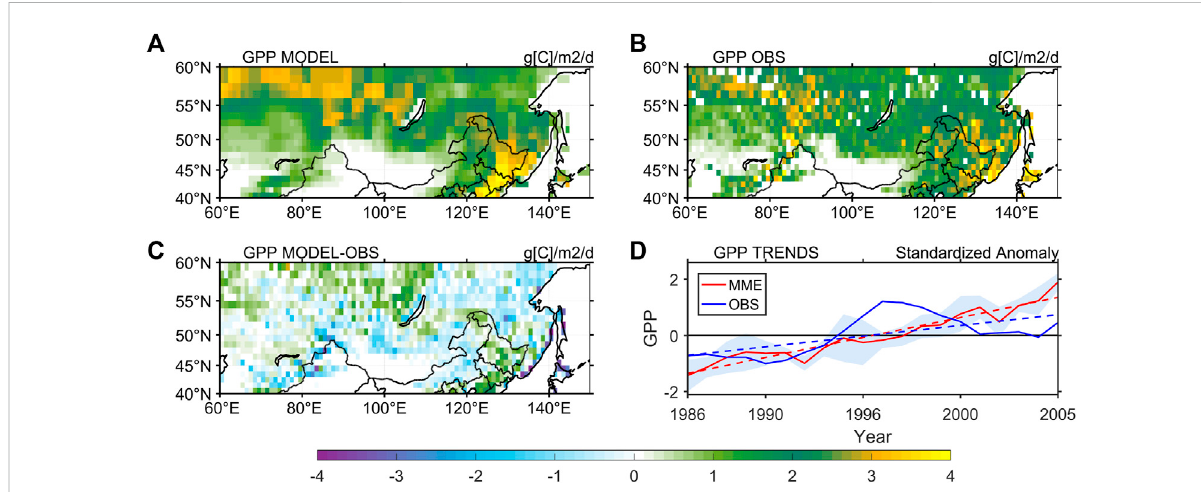
Spatial distributions of (A) ensemble simulated and (B) observed GPP (gCm − 2 d − 1 ) as well as (C) their difference (simulation-observation) in Northern Asia during the period of 1986 – 2005. (D) Time series of the normalized GPP (smoothed with a 5-years window) from the ensemble simulation (redline)and observation (blue line). Thetime seriesaresmoothedwitha5-years runningmean fi lter. Theshading indicatesthespread of the individual CMIP5